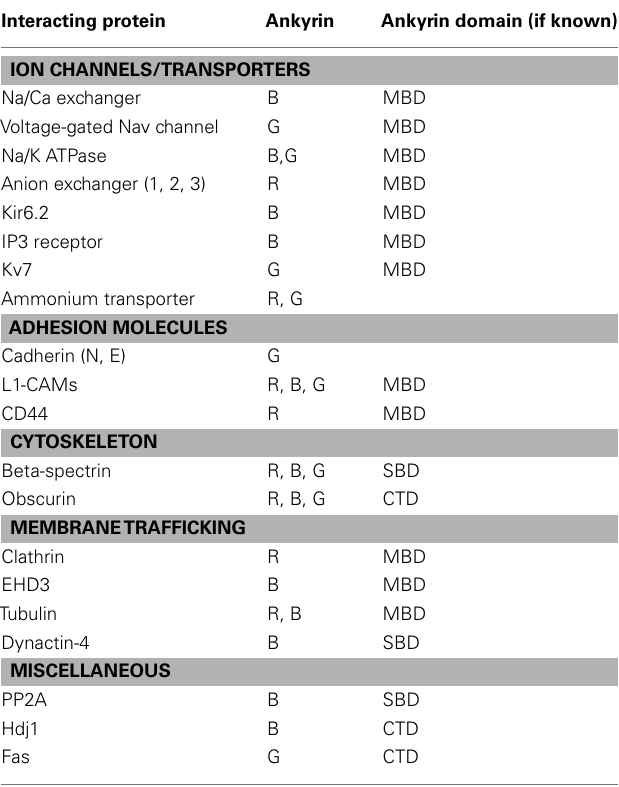
Table 1 | Select ankyrin (R, B, G) interacting proteins and site of protein